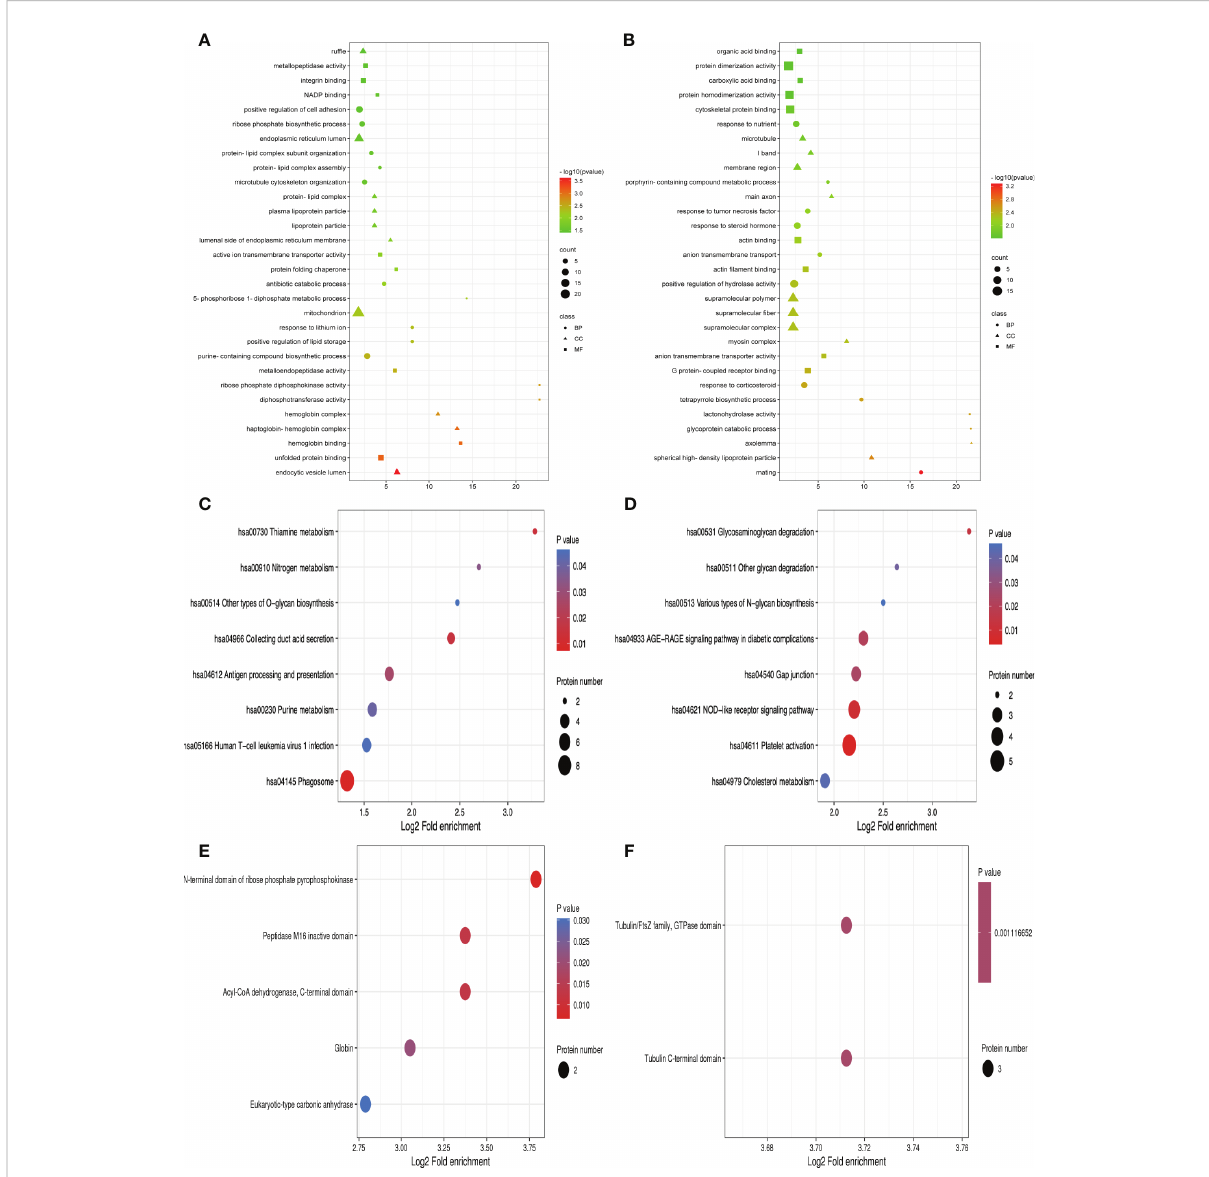
FIGURE 3 GO function, KEGG pathway, and protein domain enrichment analysis for all DEPs between groups. (A, C, E) Were the result between group A and group B, while (B, D, F) were those between group B and group D. Bubble size represents the number of DEPs; the enrichment test P value obtained by using Fisher exact test; varied color represents different P